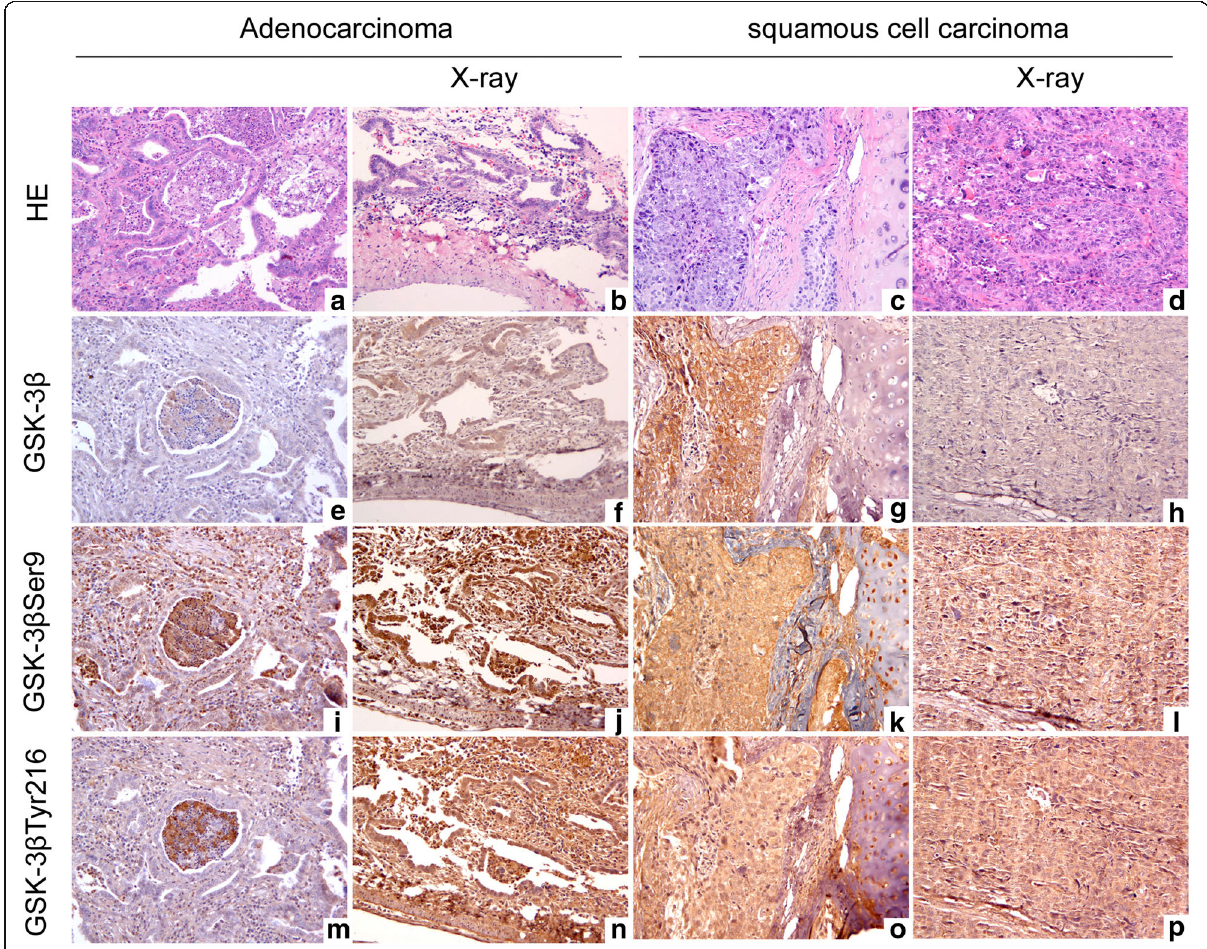
Fig. 2 GSK-3 β , p-GSK-3 β Ser9 , and p-GSK-3 β Tyr216 expression in NSCLC tissues after X-ray irradiation. a , e , i , and M are the moderately differentiated adenocarcinoma tissues without X-ray irradiation, and b , f , j , and n are the tumor tissues that received 2-Gy X-ray irradiation. a and b are stained with HE (200×); e and f have immunohistochemical staining for GSK-3 β ; i and j have immunohistochemical staining for GSK-3 β Ser9 ; and m and n have immunohistochemical staining for GSK-3 β Tyr216 . As shown in the figure, after 2-Gy X-ray irradiation of the adenocarcinoma samples, GSK-3 β expression did not change significantly, but GSK-3 β Ser9 and GSK-3 β Tyr216 expression was significantly upregulated. c , g , k , and o are the poorly differentiated squamous cell carcinoma tissues without X-ray irradiation, and d , h , l , and p are the tumor tissues that received 2-Gy X-ray irradiation. c and d are stained with HE (200×); g and h have immunohistochemical staining for GSK-3 β ; k and l have immunohistochemical staining for GSK-3 β Ser9 ; and o and p have immunohistochemical staining for GSK-3 β Tyr216 . As shown in the figure, after 2-Gy X-ray irradiation of the adenocarcinoma samples, GSK- 3 β and GSK-3 β Ser9 expression was downregulated, whereas GSK-3 β Tyr216 expression did not change